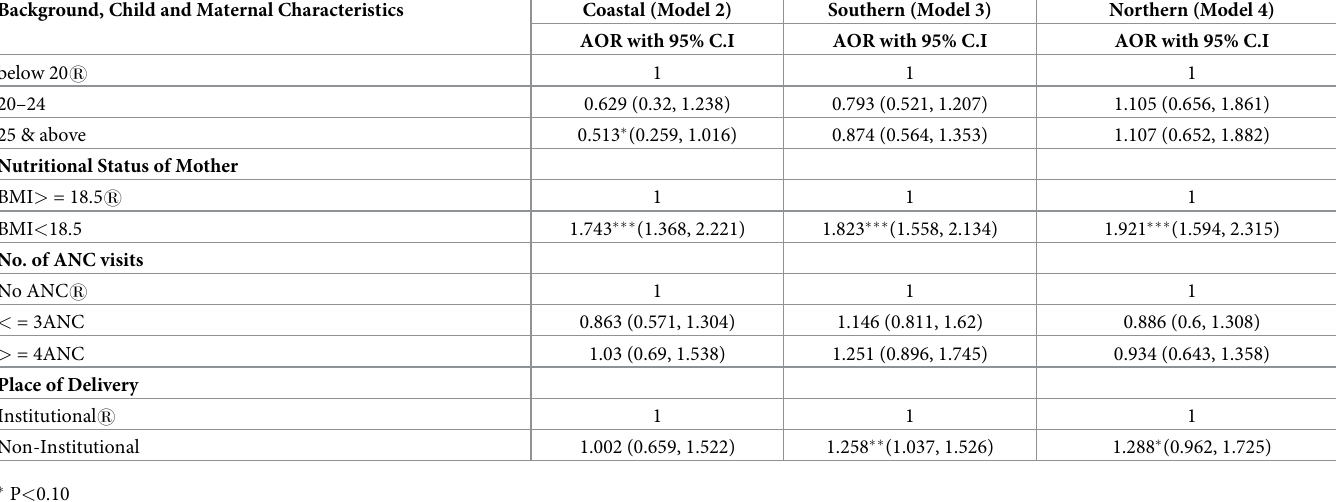
children; mothers who were highly educated had 0.58 lesser odds of their child being under- weight compared to mothers with no education. Mothers with BMI levels below normal had 1.83 higher odds of their child being underweight. Non-institutional births had 1.18 times higher odds of the child being underweight. After studying determinants of undernutrition for the state as a whole, Models 2–4 (Table 5) depict the results of a region-specific study on correlates of malnutrition. Model 2 illustrates the adjusted odds ratio for various socio-economic factors and their impact on the nutritional status of children for coastal region-specific. Results from this model show that wealth profile, social group, mother’s age, education level, and nutritional status; were found to be significantly associated with underweight in children in the coastal region. Model 3 shows that variables like age and sex of the child, wealth profile, nutritional status of the mother, and place of delivery had a significant effect on underweight children in the south- ern region. Evident growth faltering was noticed; children aged 16–18 months were 1.6 times more likely to be underweight than children below-six months of age. Mother’s education did not show a statistically significant association in this region. Model 4 depicts the adjusted odds ratio for the northern region. Variables showing significant association with children under- weight in this region were majorly age and sex of the child, type of residence, wealth profile, social group, birth interval, mother’s education and nutritional level, and place of delivery. Like the southern region, children from the northern region also suffered from growth falter- ing; 16–18 months’ children were 1.7 times more likely than children below six months to be underweight. Children from a tribal population in this region were 44% more likely to be